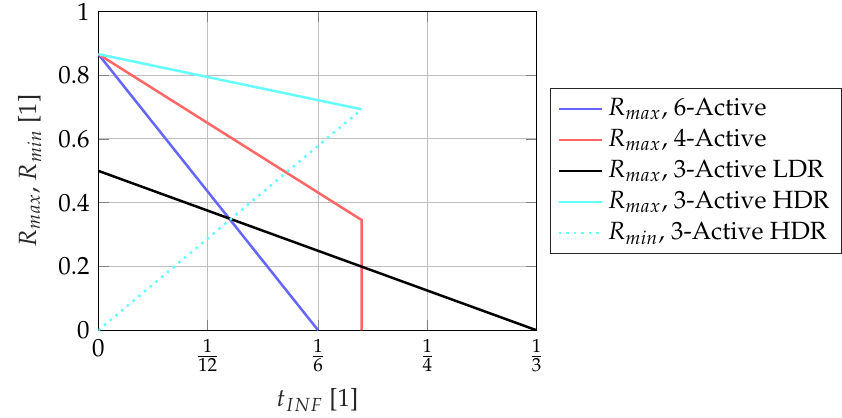
Figure 11. Comparison of the symmetrical modulation